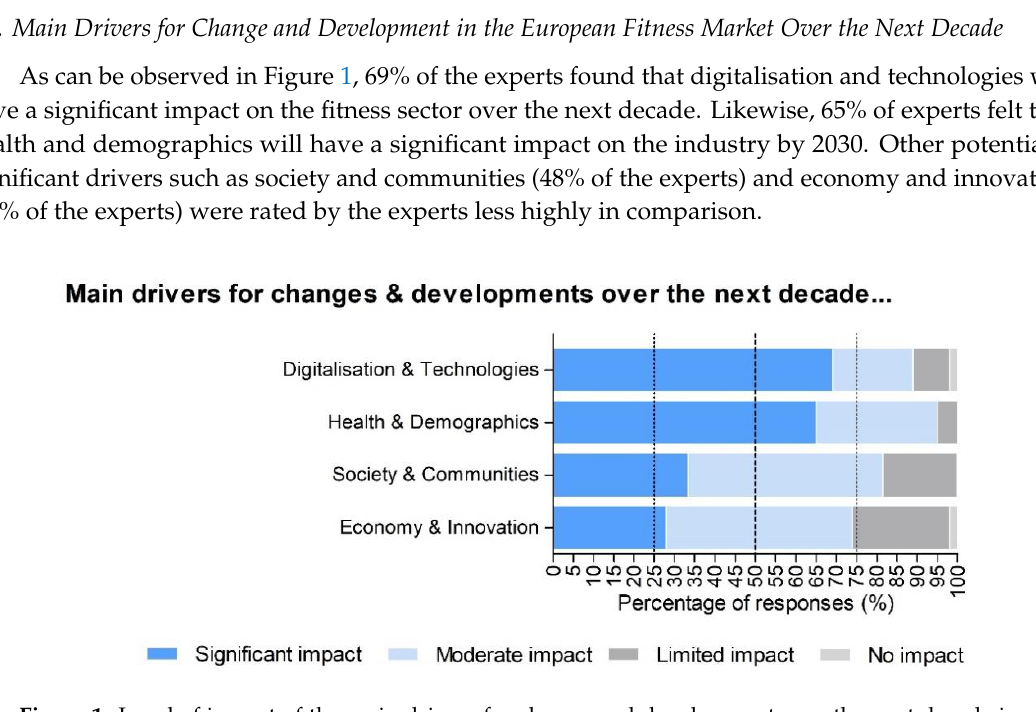
Figure 1. Level of impact of the main drivers for change and development over the next decade in percentages (%) by the experts ( n = 50). In dark blue, significant impact. In light blue, moderate impact. In black grey, limited impact. In light grey, no impact.